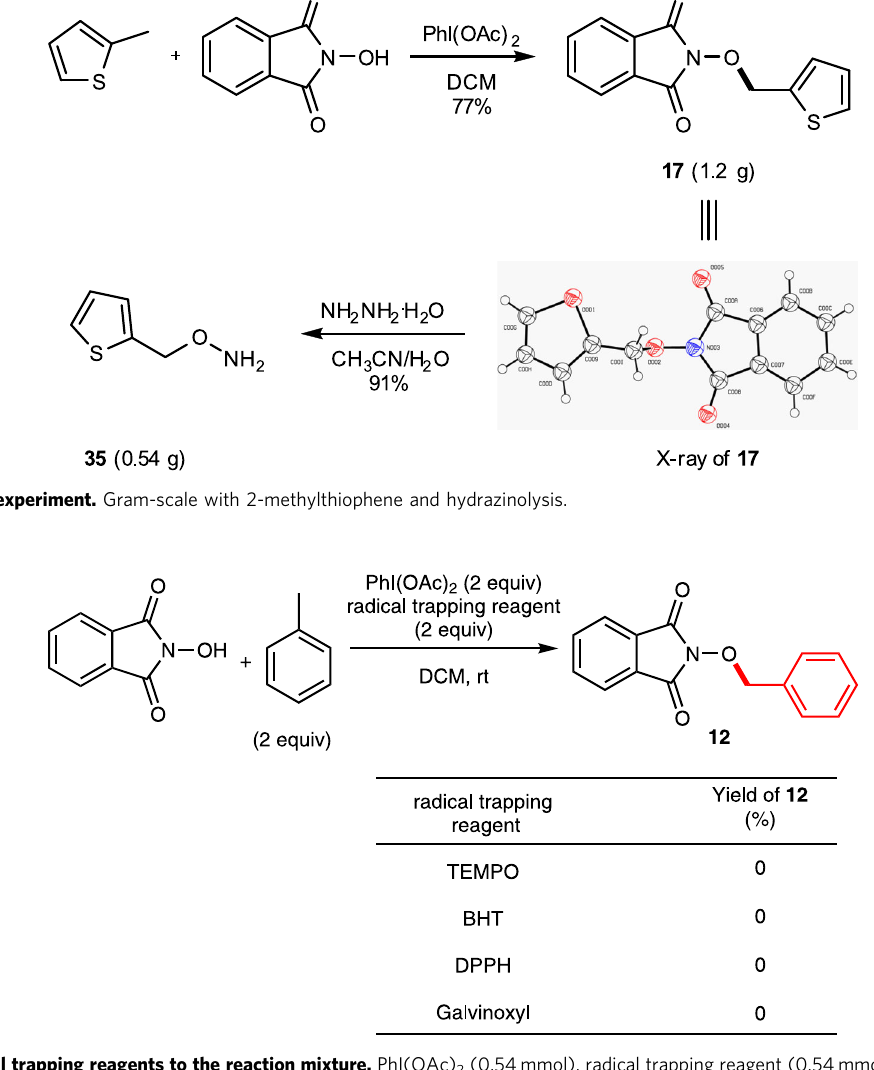
COMMUNICATIONS CHEMISTRY| (2021) 4:46